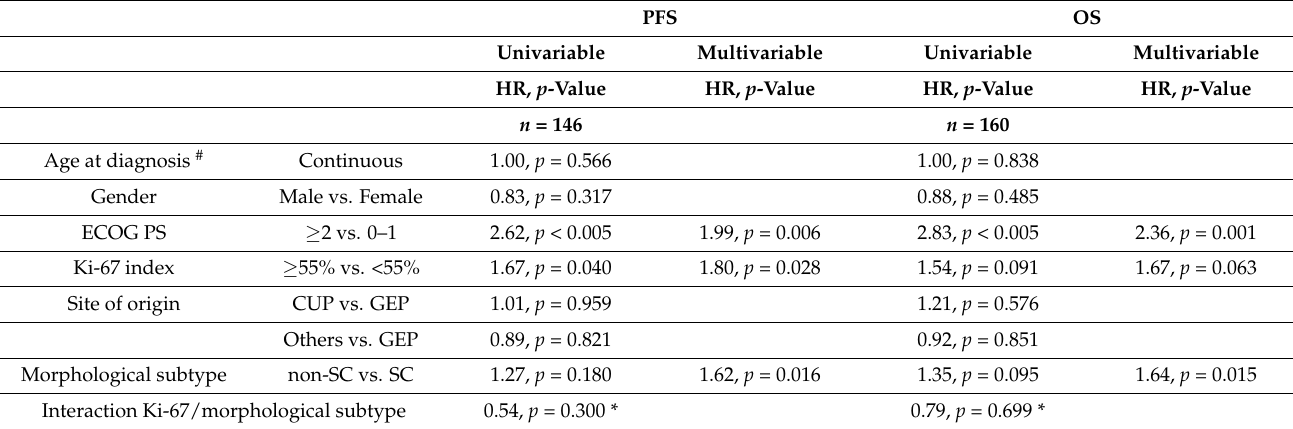
Table 2. Univariable and multivariable Cox-regression analysis for PFS and OS in patients with advanced extra-pulmonary neuroendocrine carcinoma in this study.